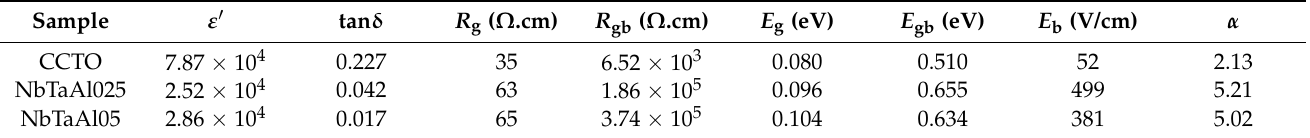
Table 2. ε (cid:48) at 10 3 Hz and 20 ◦ C, R g at 20 ◦ C, R gb at 130 ◦ C, Activation energies of grains ( E g ) and GBs ( E gb ), Breakdown electric field ( E b ), and Nonlinear coefficient ( α ) of the CCTO, NbTaAl025, and NbTaAl05 ceramics.